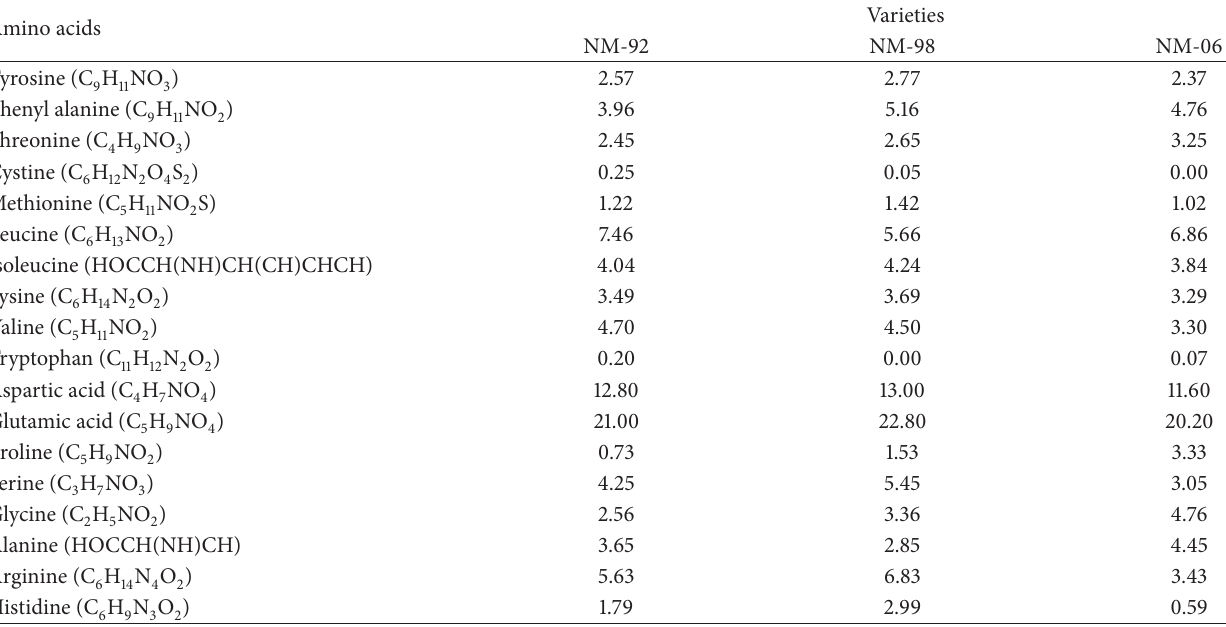
Table 2: Amino acid profile (g/100g of protein) of Vigna radiata varieties. Amino acids